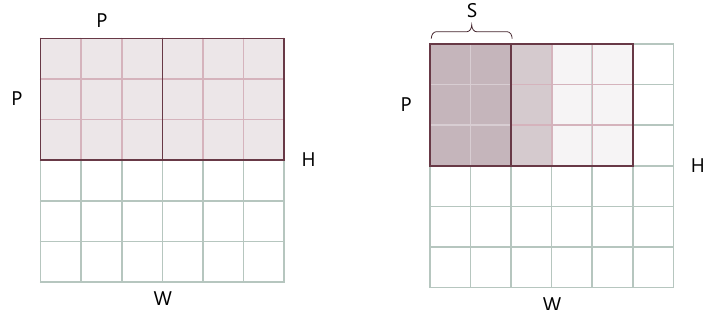
Figure 5. Non-overlapping patches ( left ) vs. overlapping patches ( right